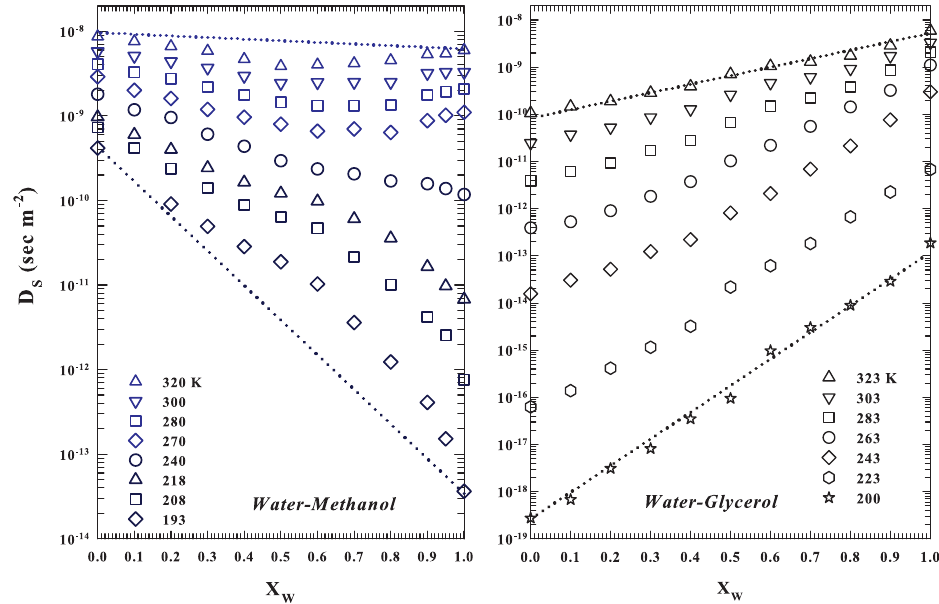
Figure 2. The two different behaviors in the D S for the methanol and glycerol solution as a function of the water molar fraction at different T . The dotted lines indicate the behavior of a non-interacting ideal mixture. The situation, within the experimental error, is that of glycerol solutions ( right panel ), where a T change affects only the slope. Instead, for the methanol solutions ( left panel ), at the highest T , a decrease in the water content corresponds, within the range 1 > X W > 0.5, to a D S decrease with a minimum at X W (cid:39) 0.5. Again, for these latter solutions, below a certain temperature in the water supercooled regime, the D S data change curvatures from concave to